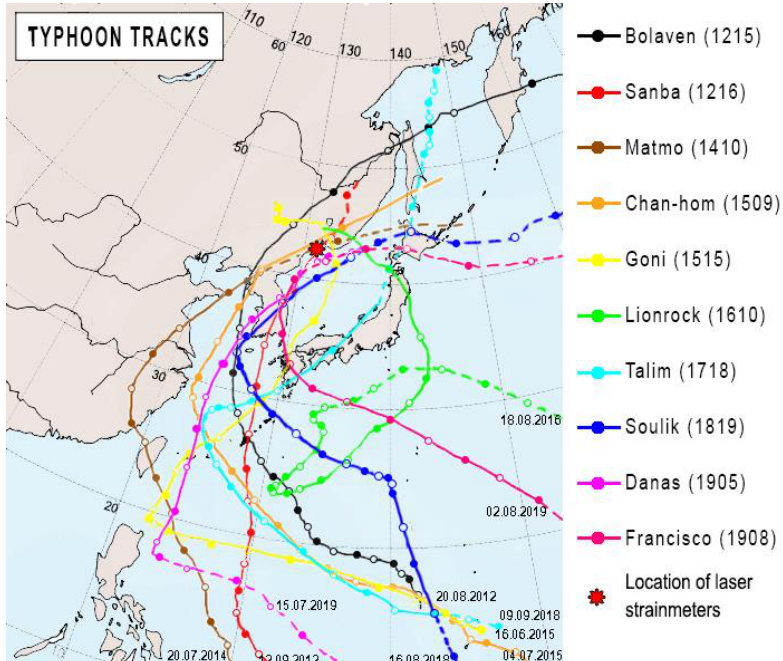
Figure 1. Scheme of tracks of typhoons, the influence of which resulted in generation of microseisms of the “voice of the sea” infrasound oscillations. (Typhoon ID number in brackets). For the detection of typhoons, data from geostationary satellites are most suitable, such as Electro-L, Resurs-P, Feng-Yun-2, Himawary-8, GOES-13, 15, 16 in the visible and near-IR range, which allow us to reveal track data: typhoon center coordinates, as well as to trace the entire life of the cyclone, determine its speed and features of the trajectory, and the turning point